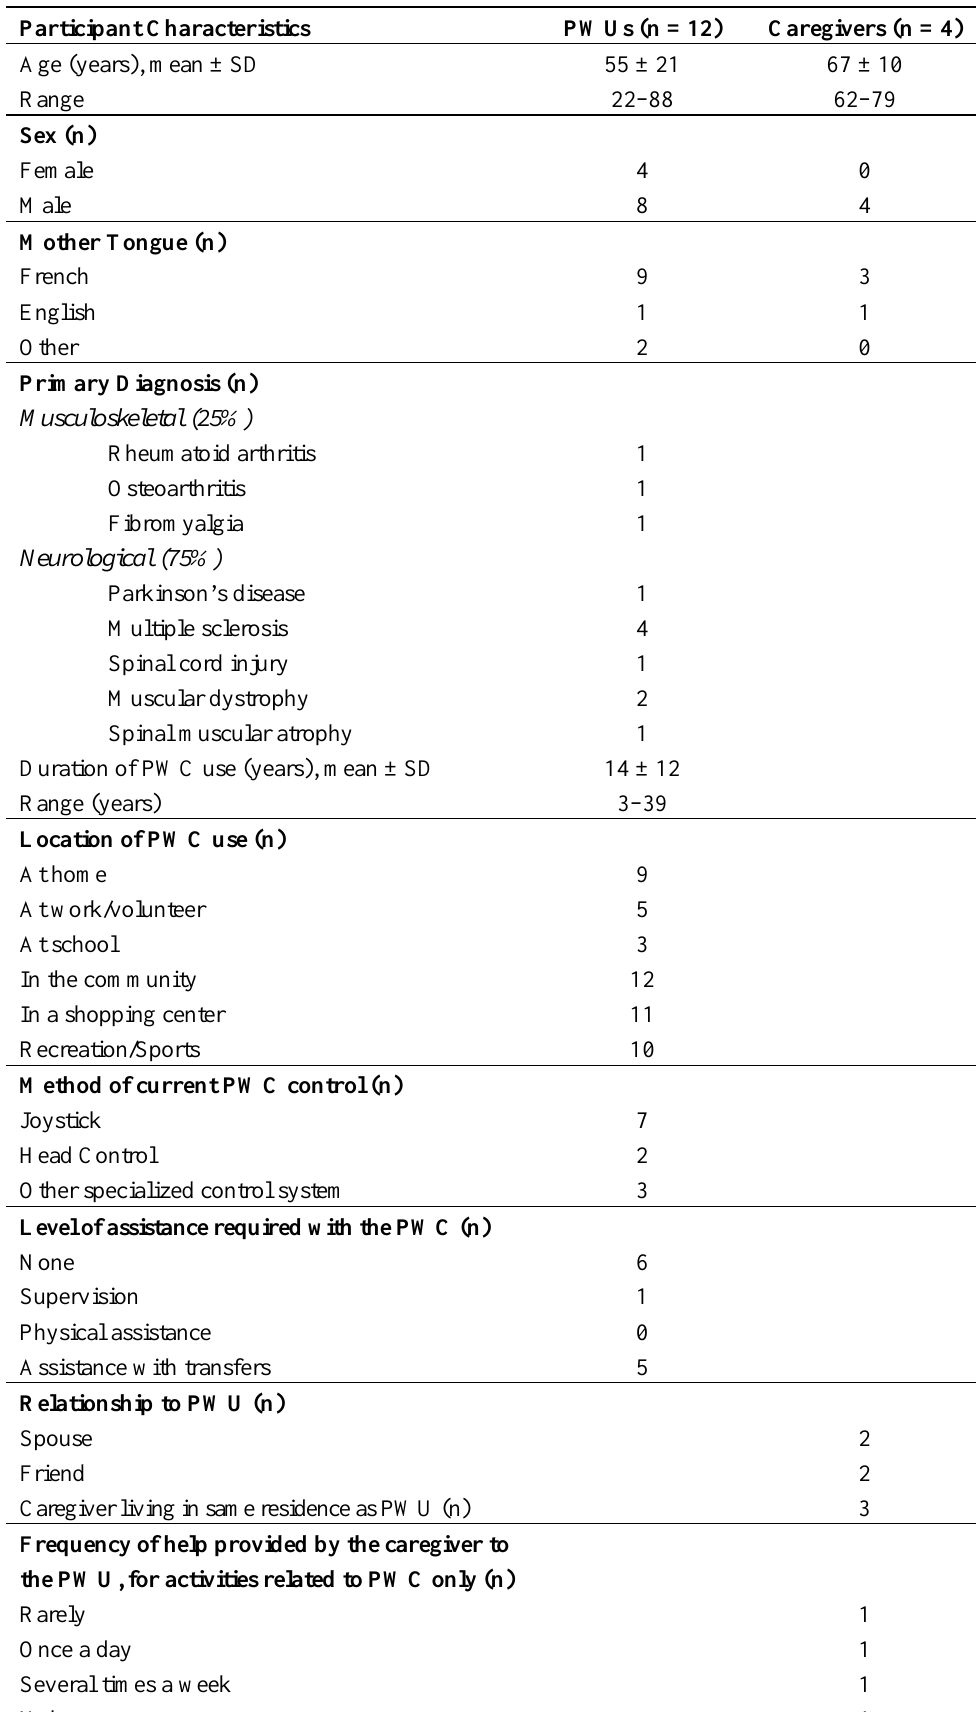
Table 1. Participant